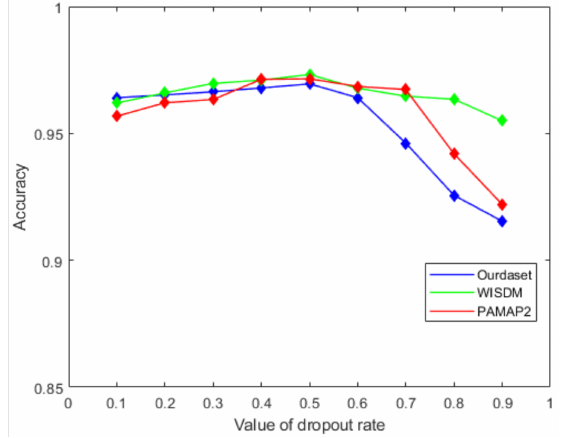
Figure 12. The effect of the value of dropout rate on recognition accuracy.